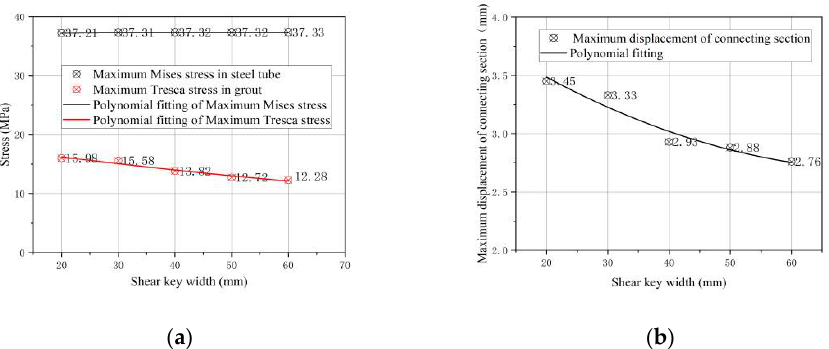
Figure 15. Variation trend of maximum stress/displacement of grouted joints with different shear bond widths. ( a ) Stress. ( b ) Displacement.